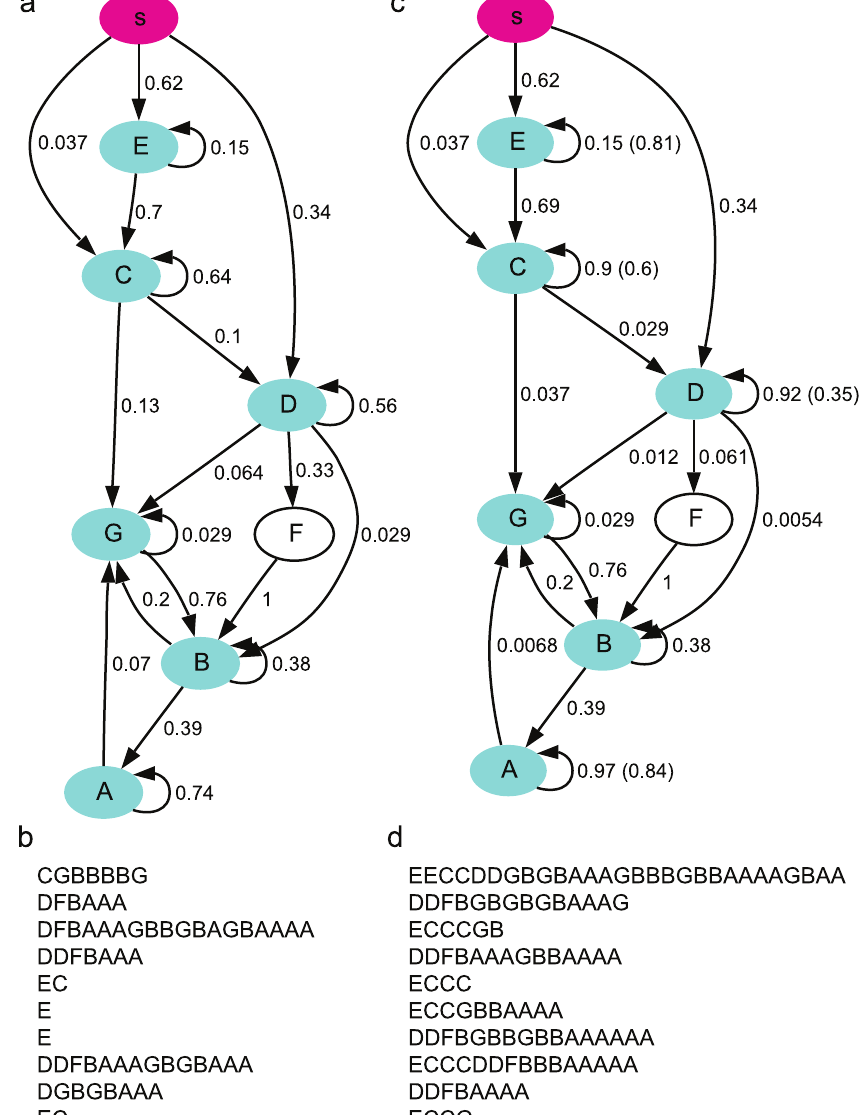
Figure 2. The Markov syntax of the syllable sequences (Bird 1). a . The Markov model. The pink oval represents the start state. The end state is not shown. The cyan ovals are the states with finite probabilities of transitioning to the end state. The numbers near the transition lines indicate the transition probabilities. b . Examples of syllable sequences generated from the Markov model. c . The Markov model with adaptation. The numbers in parenthesis are the adaptation parameter a . d . Examples of syllable sequences generated from the Markov model with adaptation.